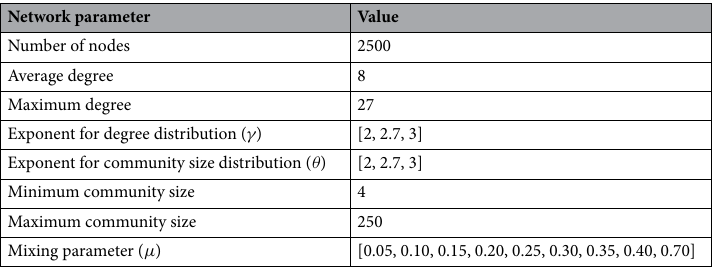
Table 1. Synthetic network parameters generated by the LFR model.